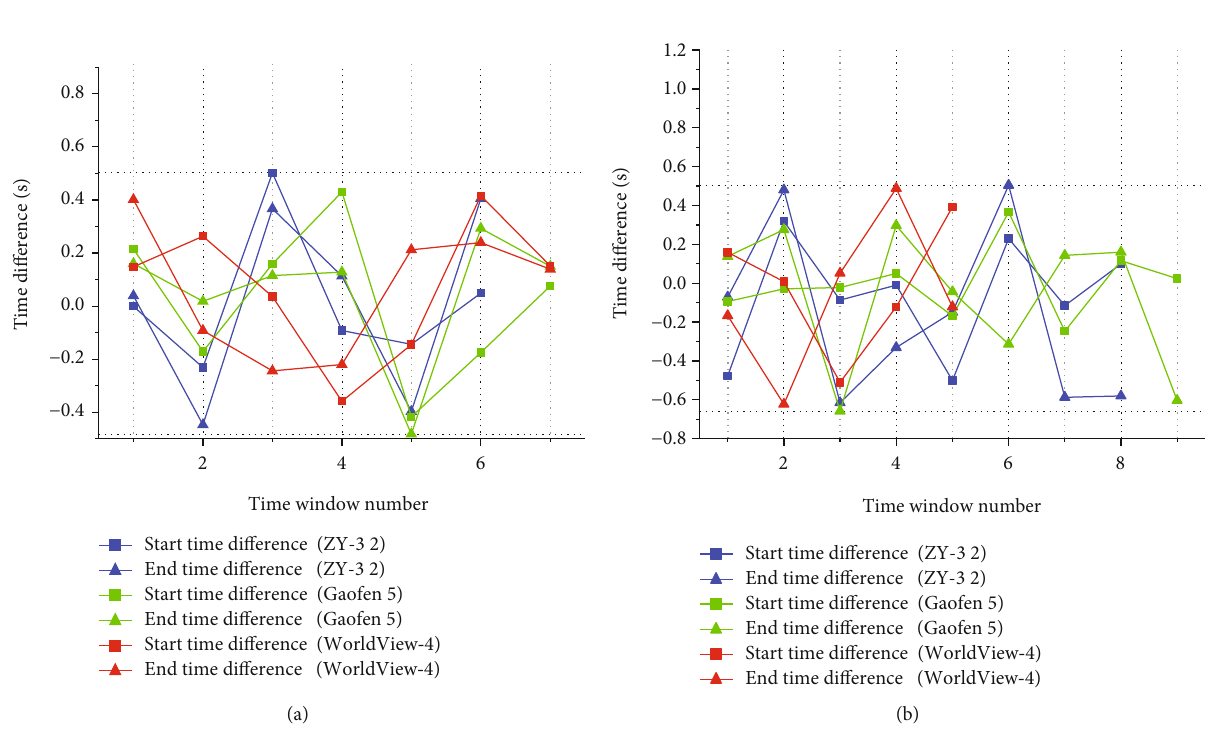
Figure 12: Comparison of calculation results: (a) ground area 1; (b) ground area 2. Table 4: Comparison of the coverage